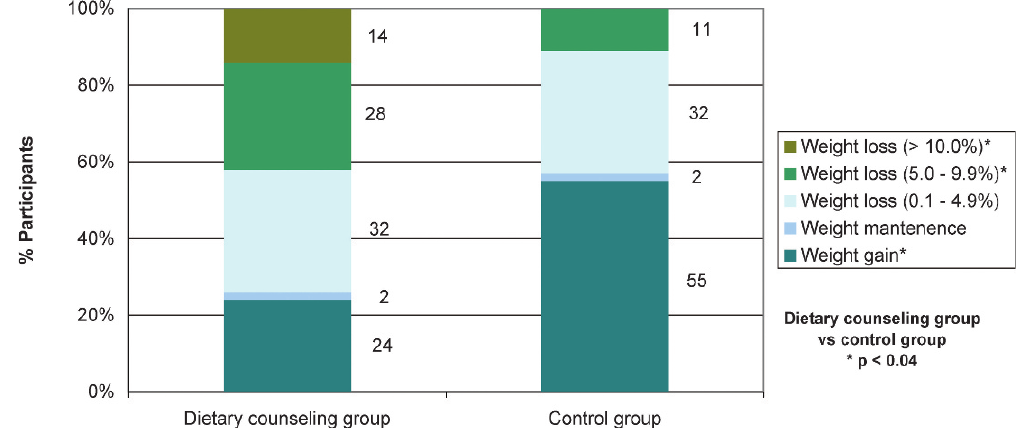
Figure 2 - Stratification of participants according to percentage change in body weight in both study